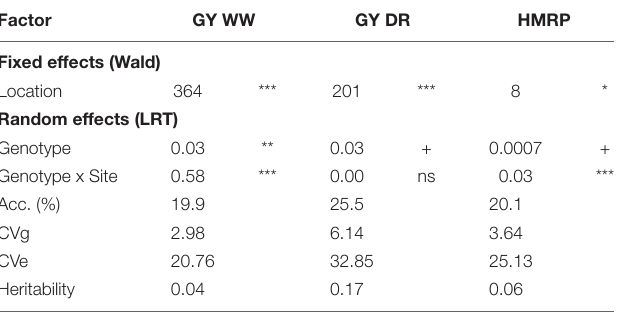
TABLE 3 | Wald statistic for fixed effects and variance components for random effects to the joint analysis (second stage) for the three traits, grain yield under well-watered (GY WW) and drought (GY DR) and the drought tolerance index (HMRP). Factor GY WW GY